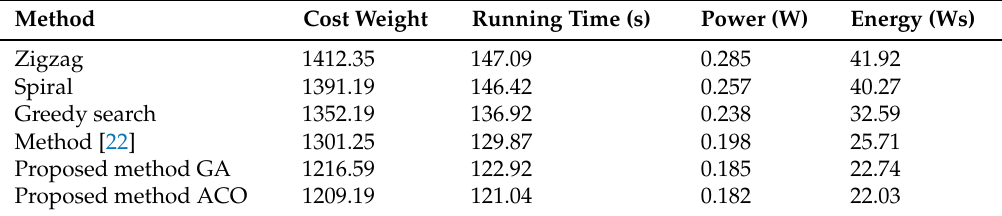
Table 10. Path Planning Performance Table on Real workspace of 6 × 6 size.